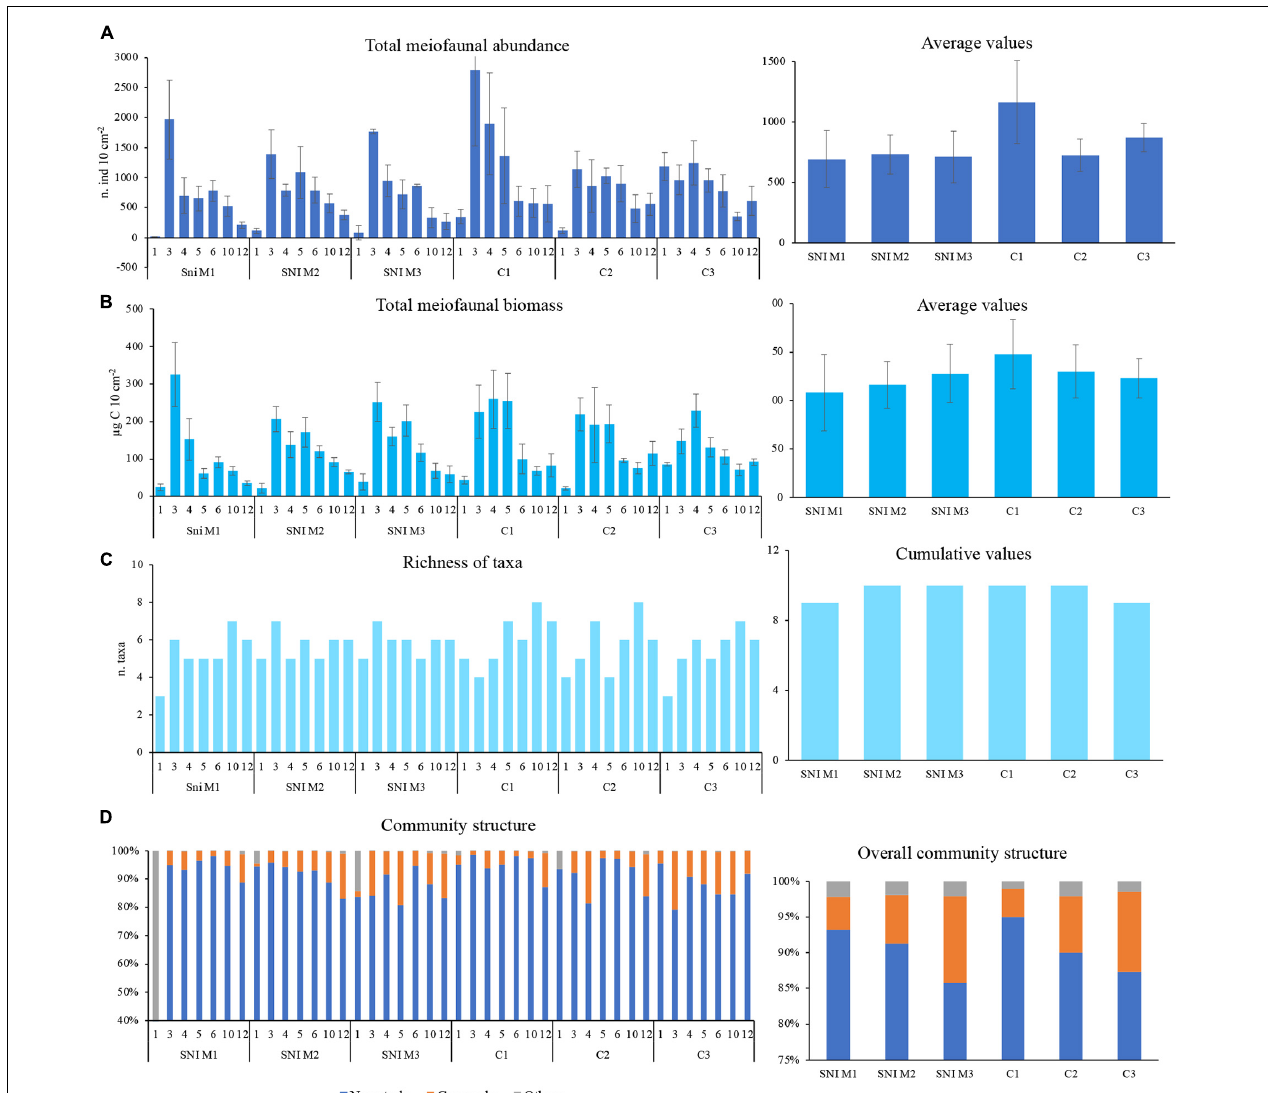
FIGURE 4 | Bathymetric distribution of meiofaunal abundance, biomass and community structure in the sediments of SNI (M1, M2 and M3) and control (C1, C2 and C3) transects. (A) Meiofauna abundances in the different stations (on the left) and transects and their average values (on the right), (B) biomasses in the different stations and transects (on the left) and their average values (on the right); (C) richness of taxa in the different stations and transects (on the left) and their cumulative values (on the right), and (D) community structure in the different stations and transects (on the left) and their overall community structure (on the right). The group “Others” contains Polychaeta, Kinorhyncha, Bivalvia, Acarina, Cumacea, Amphipoda, Gastropoda, Cladocera, Ostracoda, and